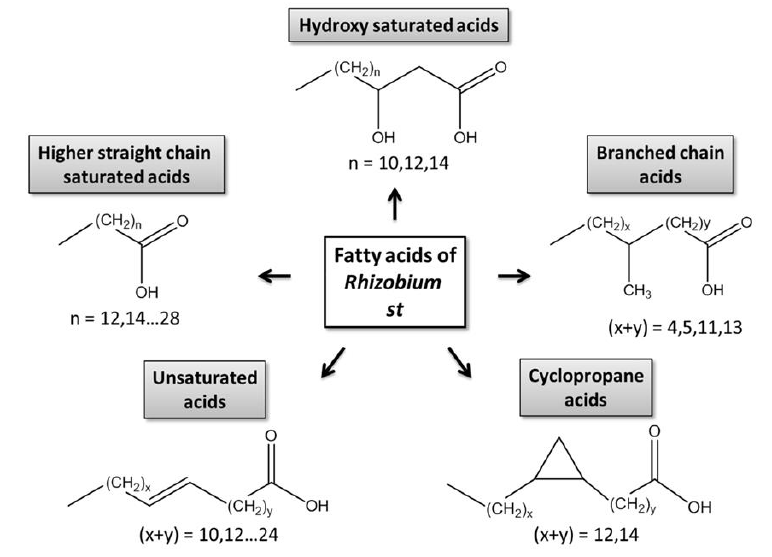
Figure 1. Structural classes of bacterial fatty acids.